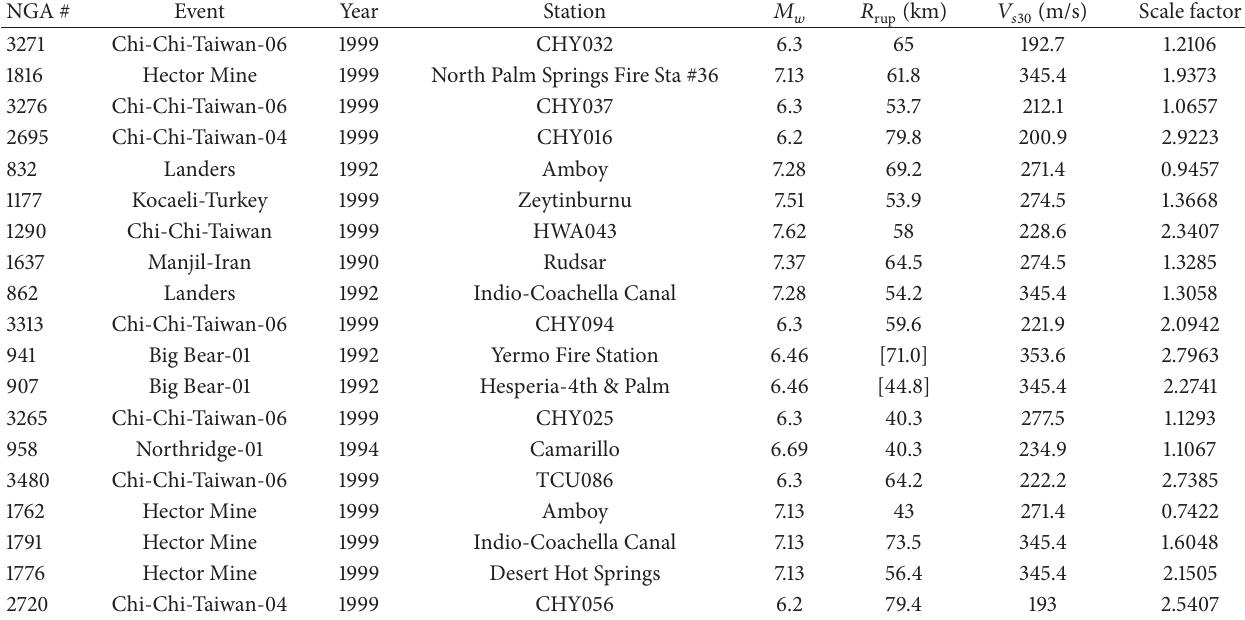
Table 4: Selected ground motion records for site class D.